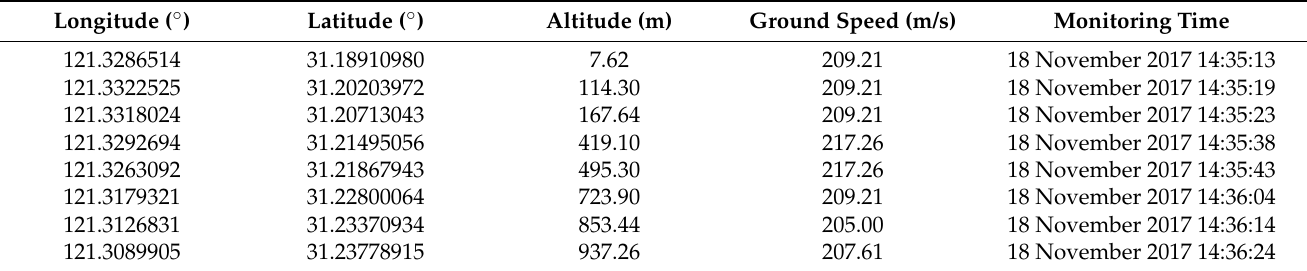
Table 1. Trajectory data illustration for manned